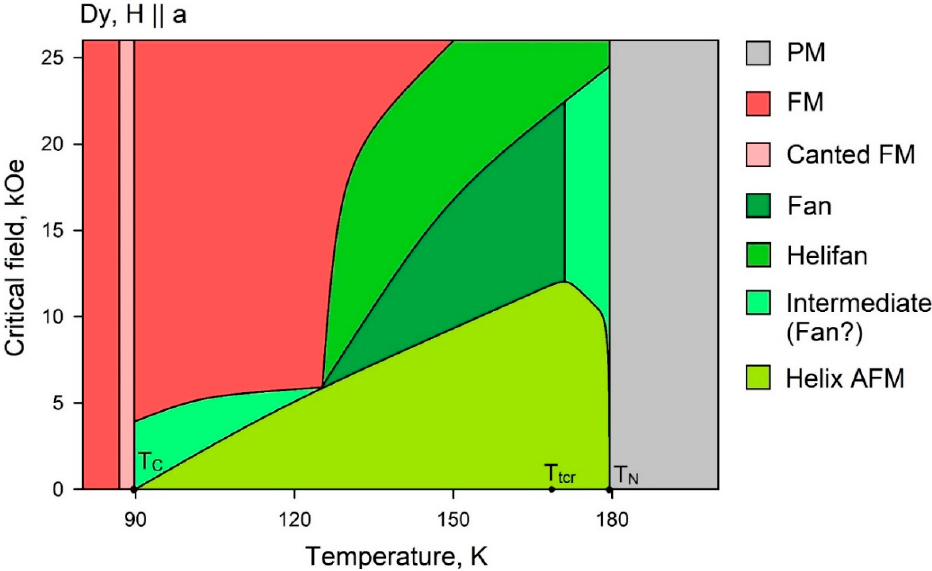
Figure 4. Magnetic phase diagram of Dy. The experimental data has been taken from